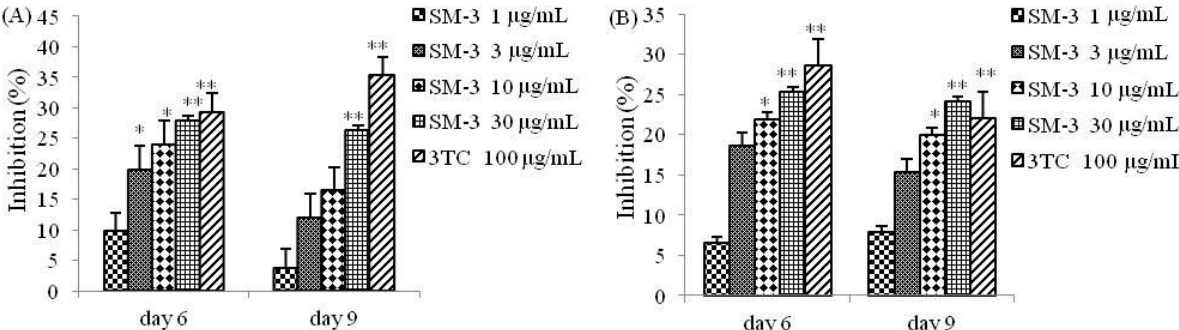
Figure 2. Inhibition of HBsAg and HBeAg secretion by SM-3 and